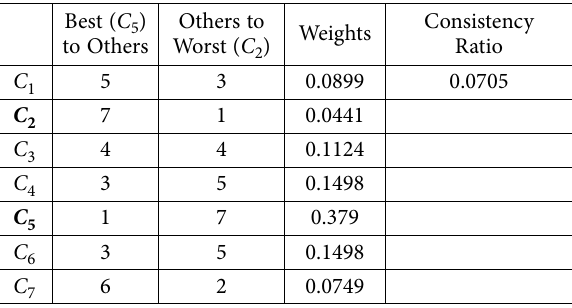
Table 6. The weights of decision criteria by BWM